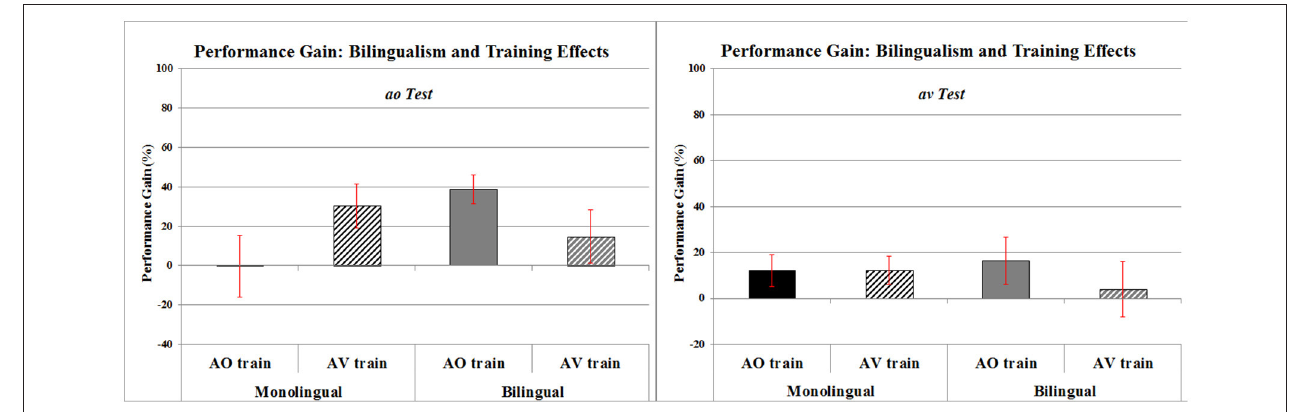
FIGURE 5 | Mean percentage of Pre- to Post-training performance gain for Mandarin Tone Perception including effects of Bilingualism (Mono- vs. Bi-), Training (AO vs. AV) and Test Types (ao vs. av). Error bars represent standard errors.